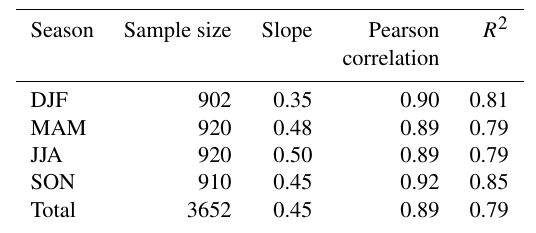
Table 1. Statistics of Fig. 2. Indicated are the sample size, the slope of a linear fit between the two rainfall products ( R A and R U ; the dashed colored lines in Fig. 2) for all observations and the Pearson correlation coefficient. This is indicated per season (DJF is winter, MAM is spring, JJA is summer and SON is autumn) and for all seasons together (Total).